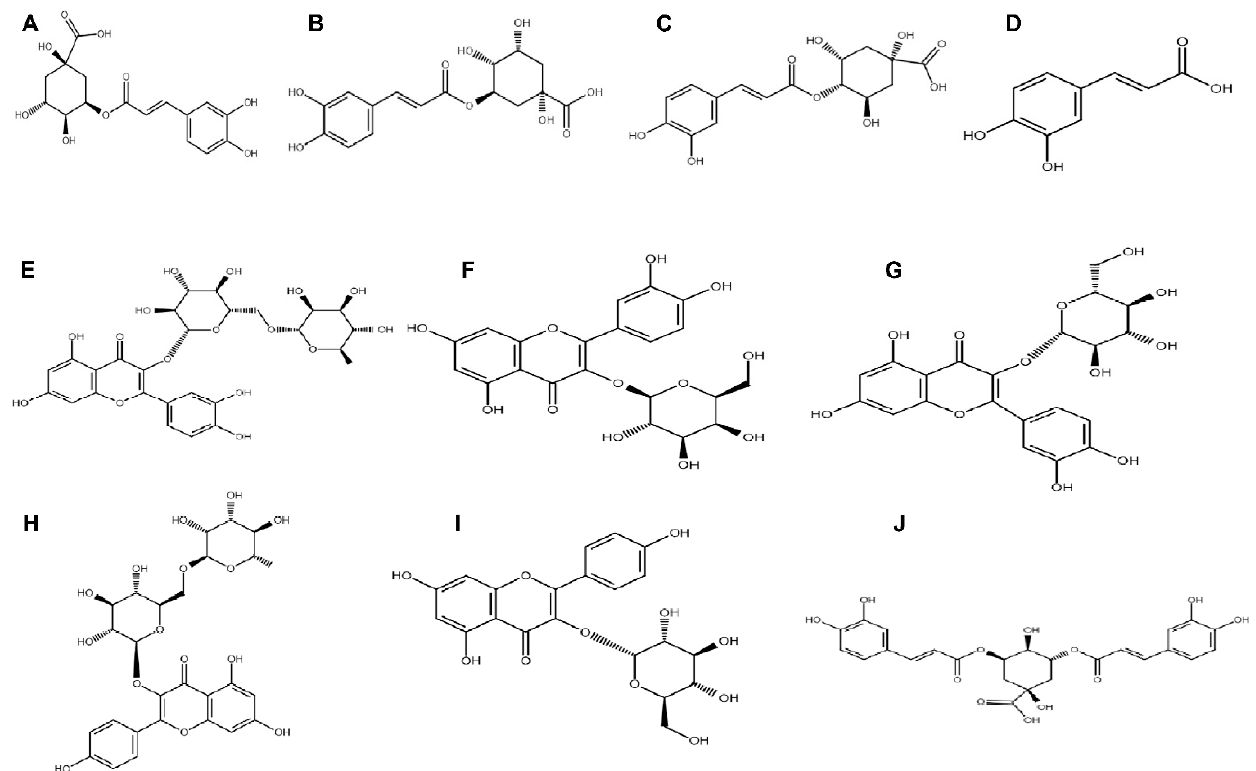
Figure 1. Chemical structure of the analytical standards: ( A ) Neochlorogenic acid, ( B ) Chlorogenic acid, ( C ) Cryptochlorogenic acid, ( D ) Caffeic acid, ( E ) Quercetin 3-rutinoside, ( F ) Quercetin 3-galactoside, ( G ) Quercetin 3-glucoside, ( H ) Kaempferol 3-rutinoside, ( I ) Kaempferol 3-glucoside, and ( J ) Isochlorogenic acid.